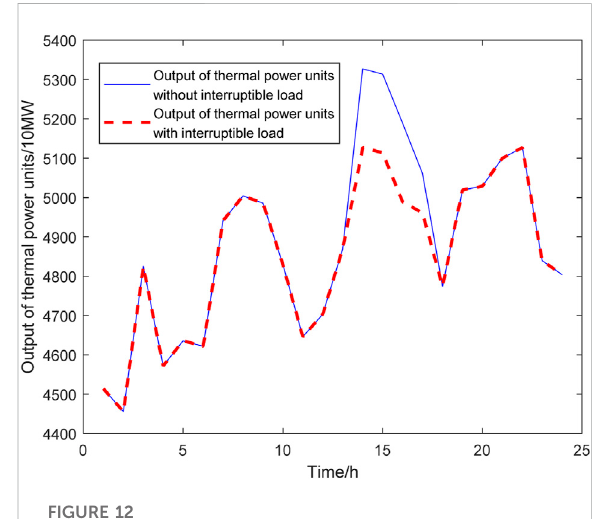
FIGURE 14 Comparison of the output of thermal power units on typical day 2 with 6 million kW interruptible